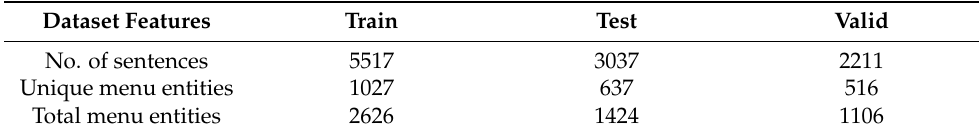
Table 1. Description of annotated menu